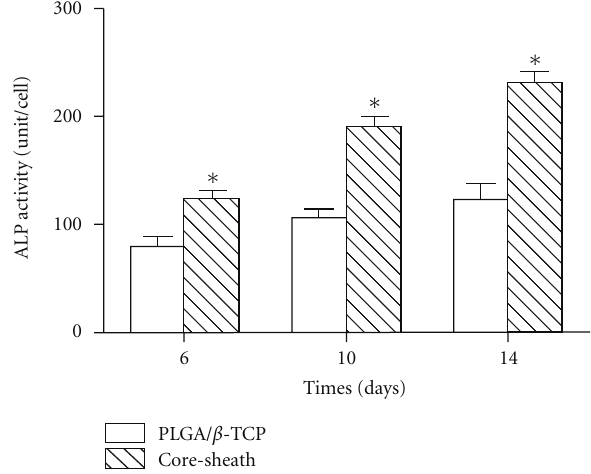
Figure 4: ALP activity comparisons on the core-sheath structure composite sca ff old and the PLGA/ β -TCP skeleton. Each value and error bar represent the mean of triplicate samples and their standard deviation ( ∗ P < 0 . 05 compared with the PLGA/ β -TCP sca ff olds; n =